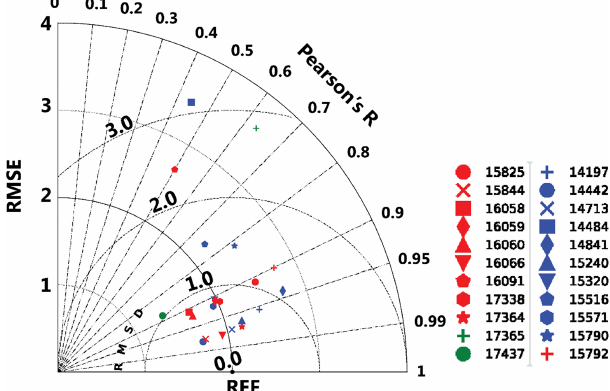
Figure 6. Modified Taylor diagram (Taylor, 2001) summarizing model performance in terms of RMSE, Pearson R and centered RMSD. The point labeled “REF” represents a reference value for RMSE from Yearsley (2012).